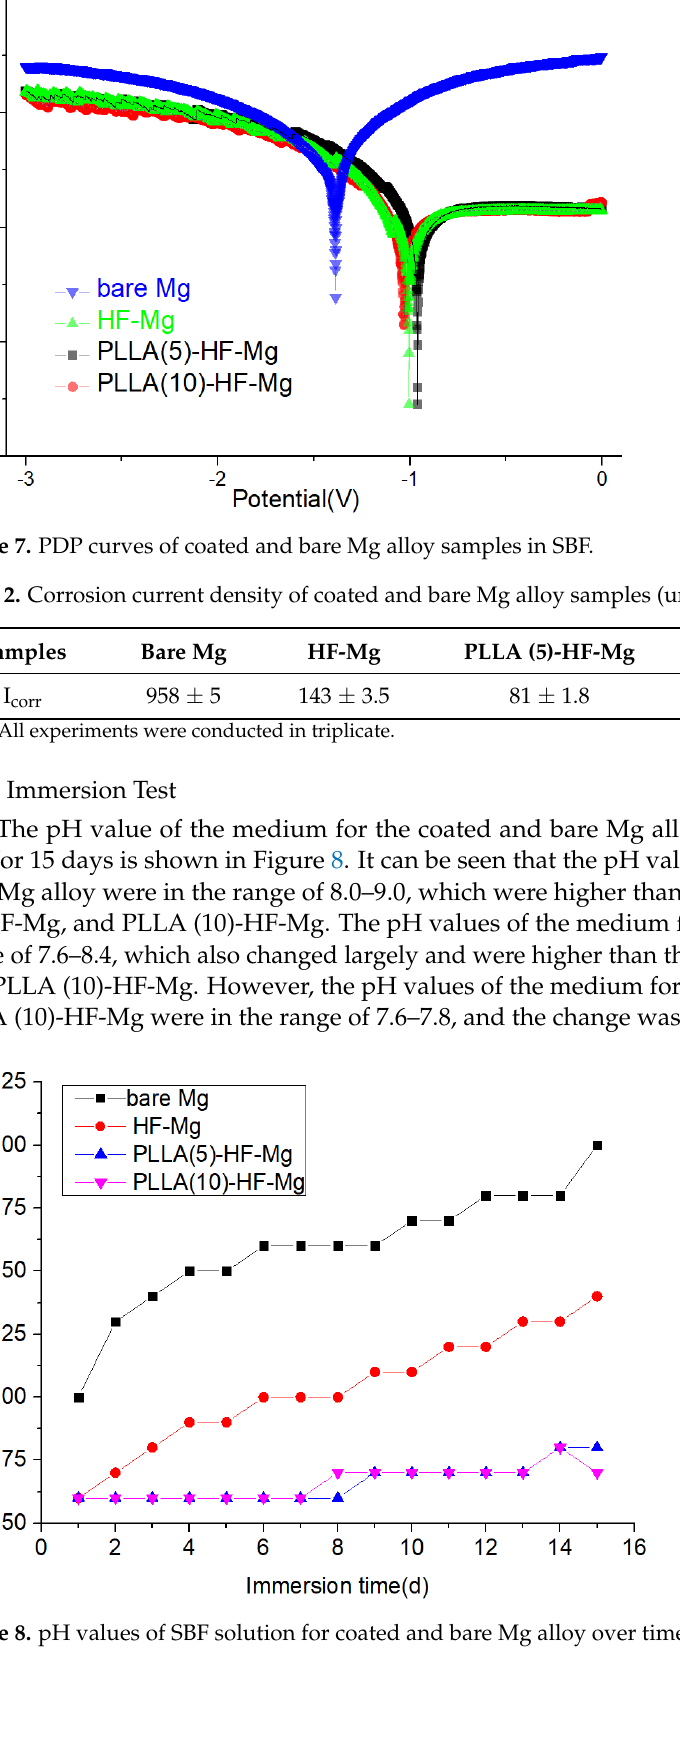
Figure 9. SEM image of all samples after immersion in SBF for 15 days ( a ) bare Mg, ( b ) HF-Mg and ( c ) PLLA (5)-HF-Mg, ( d ) PLLA (10)-HF-Mg. The element content of the corrosion surface of all samples after immersion in SBF for 15 days analyzed by EDS is shown in Figure 10. In this study, the bare Mg alloy’s surface had the highest content of O of 52.96%. On the corrosion surface of HF-Mg, the content of F was 27.93%, which was the highest. The content of F was low on the surface of PLLA (5)-HF-Mg and was almost zero on the surface of PLLA (10)-HF-Mg. While the main element in PLLA is C and O, the content of C is high on the surface of PLLA (5)-HF- Mg and PLLA (10)-HF-Mg.